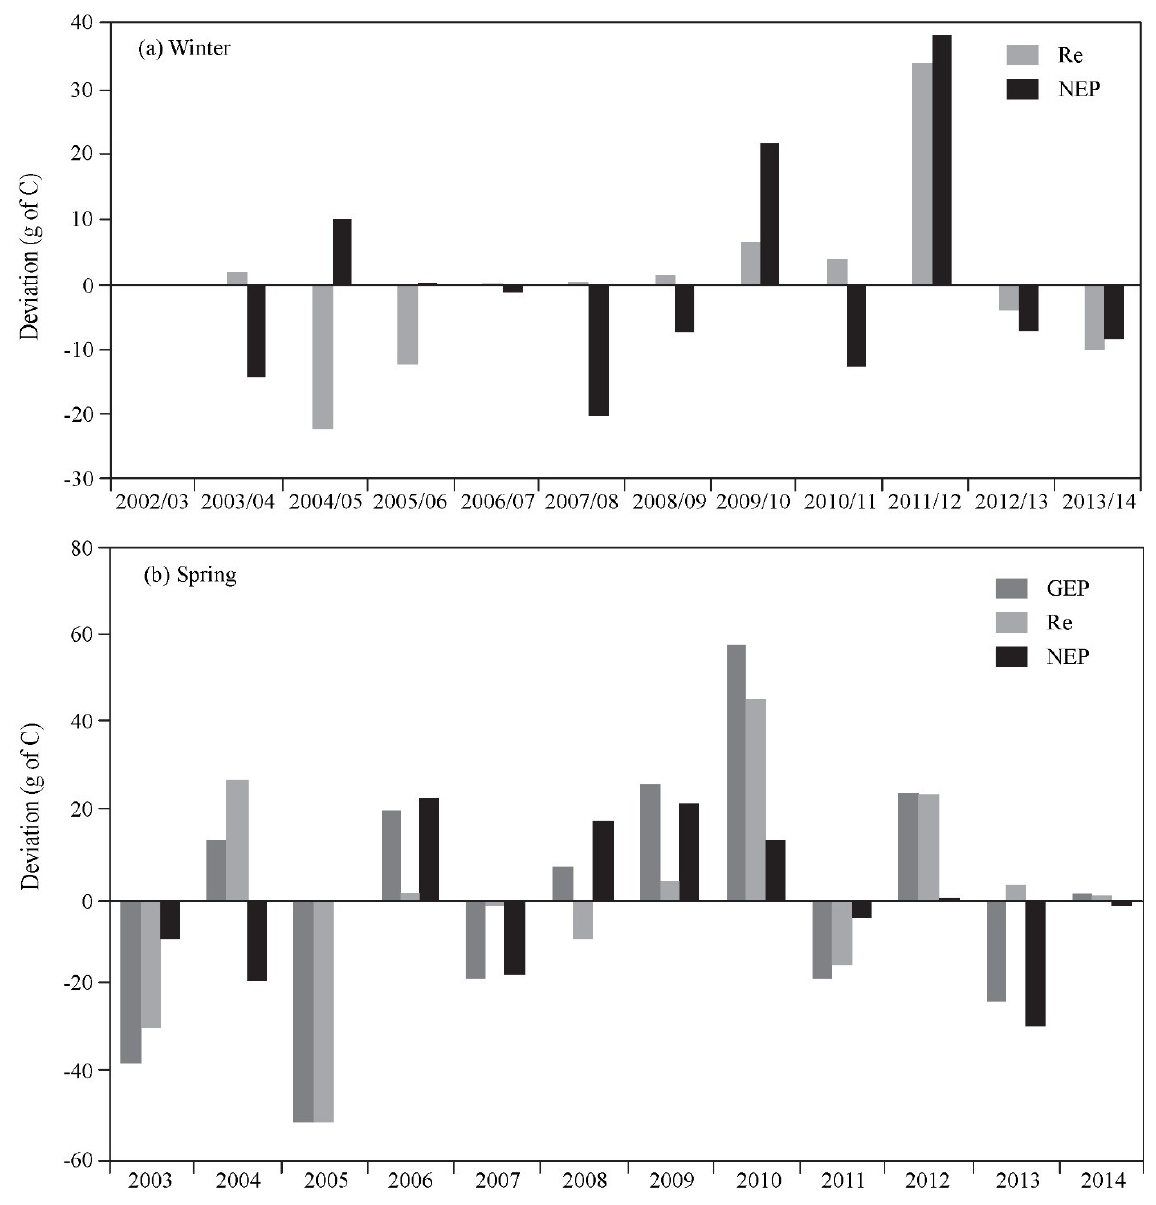
Figure 4. ( a ) Winter and ( b ) spring deviations from the mean gross ecosystem productivity (GEP), ecosystem respiration (Re) and net ecosystem productivity (NEP) over the period of 2003 to 2014. GEP for the winter season was not included as little or no photosynthesis occurred during the winter season in the